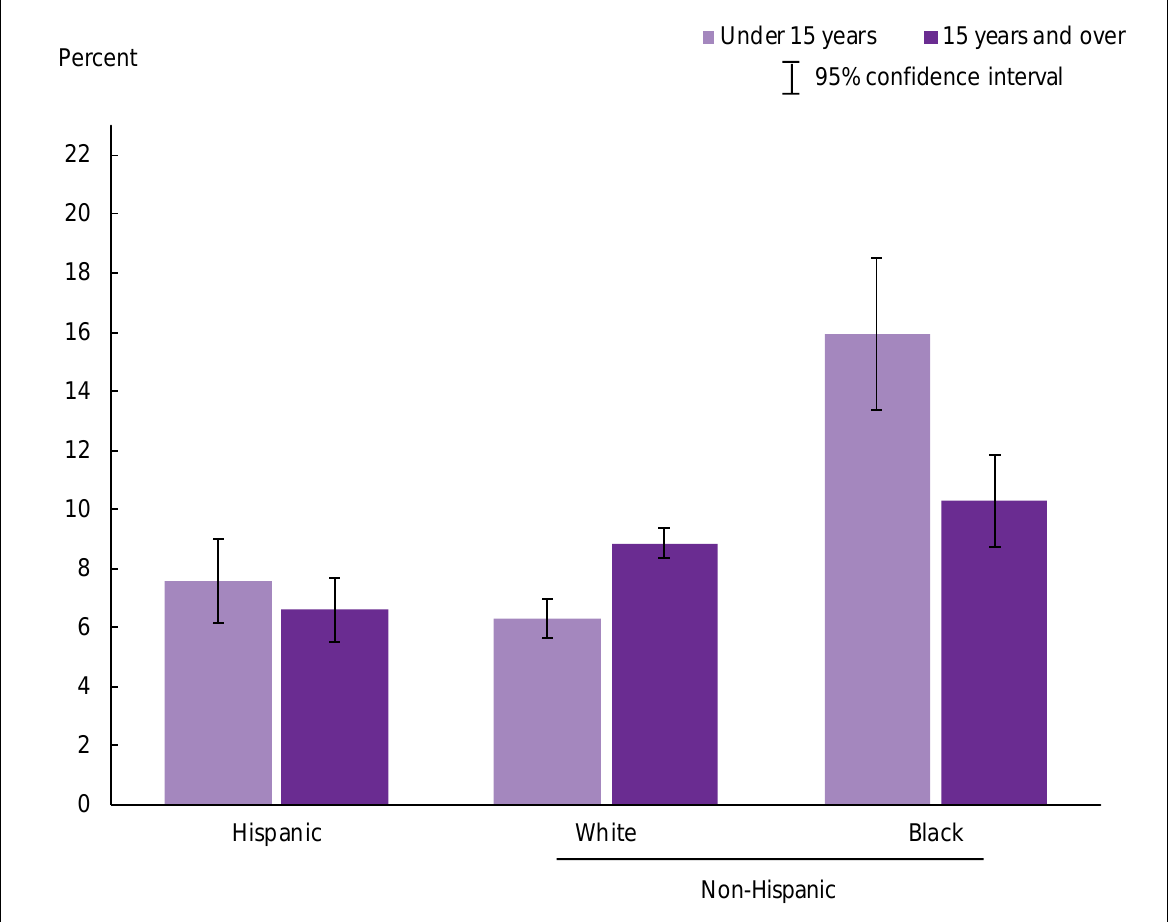
Figure 15.6. Sex-adjusted prevalence of current asthma among persons of all ages, by age group and race and ethnicity: United States,